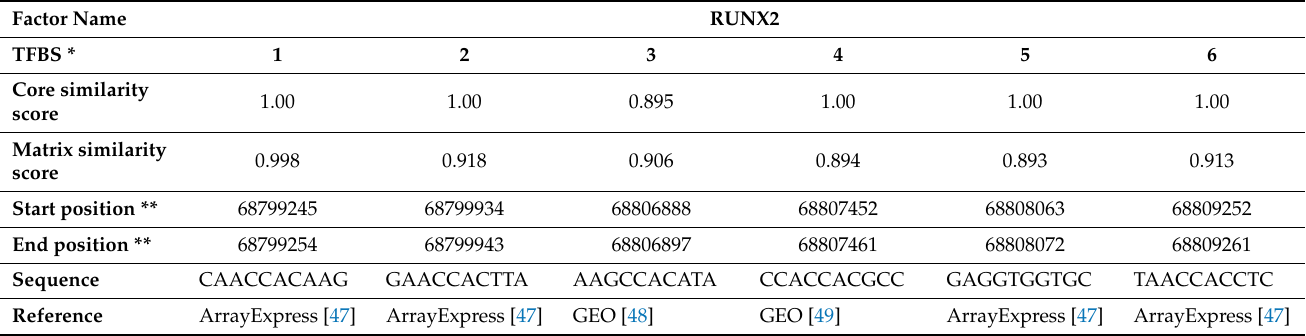
Table 7. RUNX2 transcription factor binding sites within MDM2 promoter.